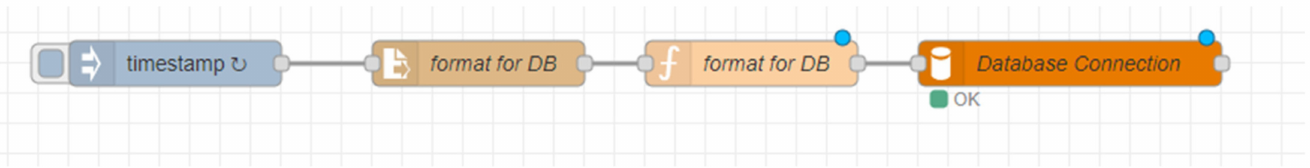
Figure 13. Nodered flow—PLC to MySQL and 3DExperience.